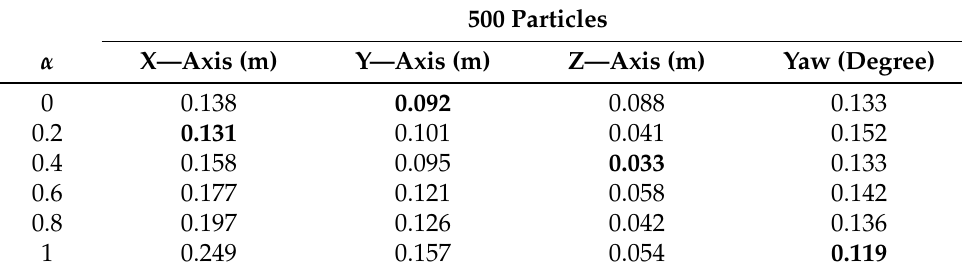
Table 3. RMS errors with different values of α using 500